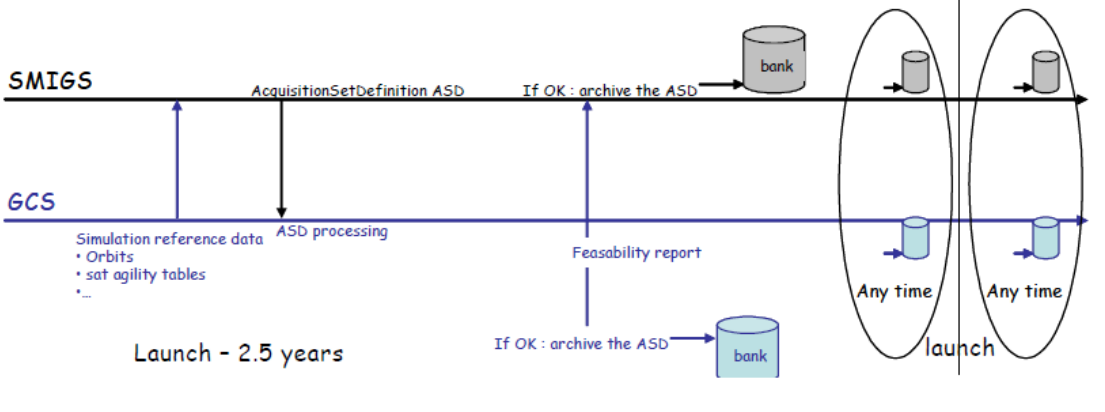
Figure 34. Scientific mission process.